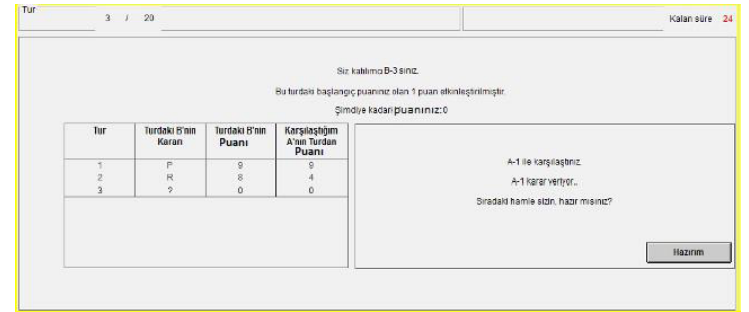
Figure A2. Type B’s Screen